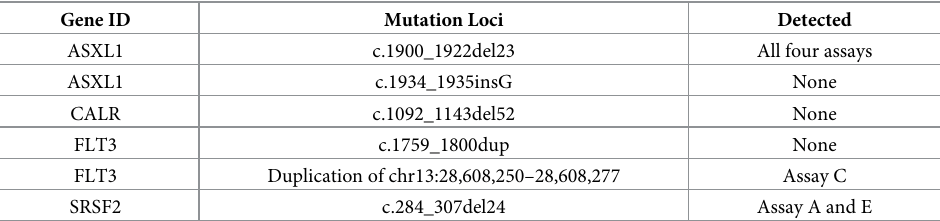
Table 4. Detection of the Challenging mutations at 1% VAF and 50 ng DNA